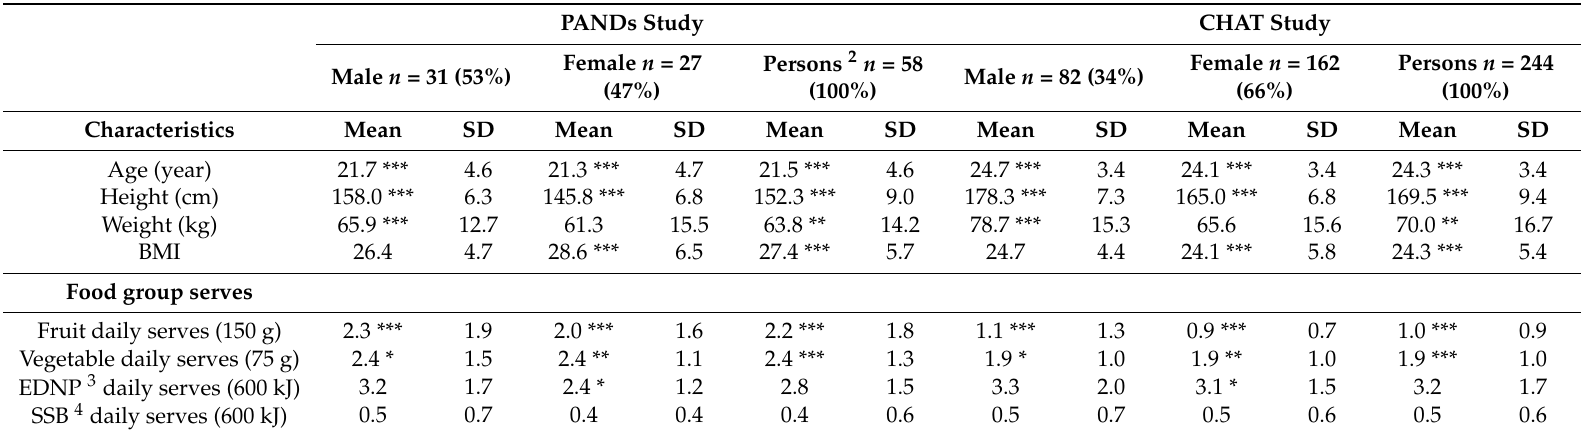
Table 1. Characteristics of participants in the (Physical Activity, Nutrition and Down syndrome) (PANDs 1 ) and Connecting Health and Technology (CHAT) studies who completed a food record using the mobile food record (mFR) app. PANDs Study